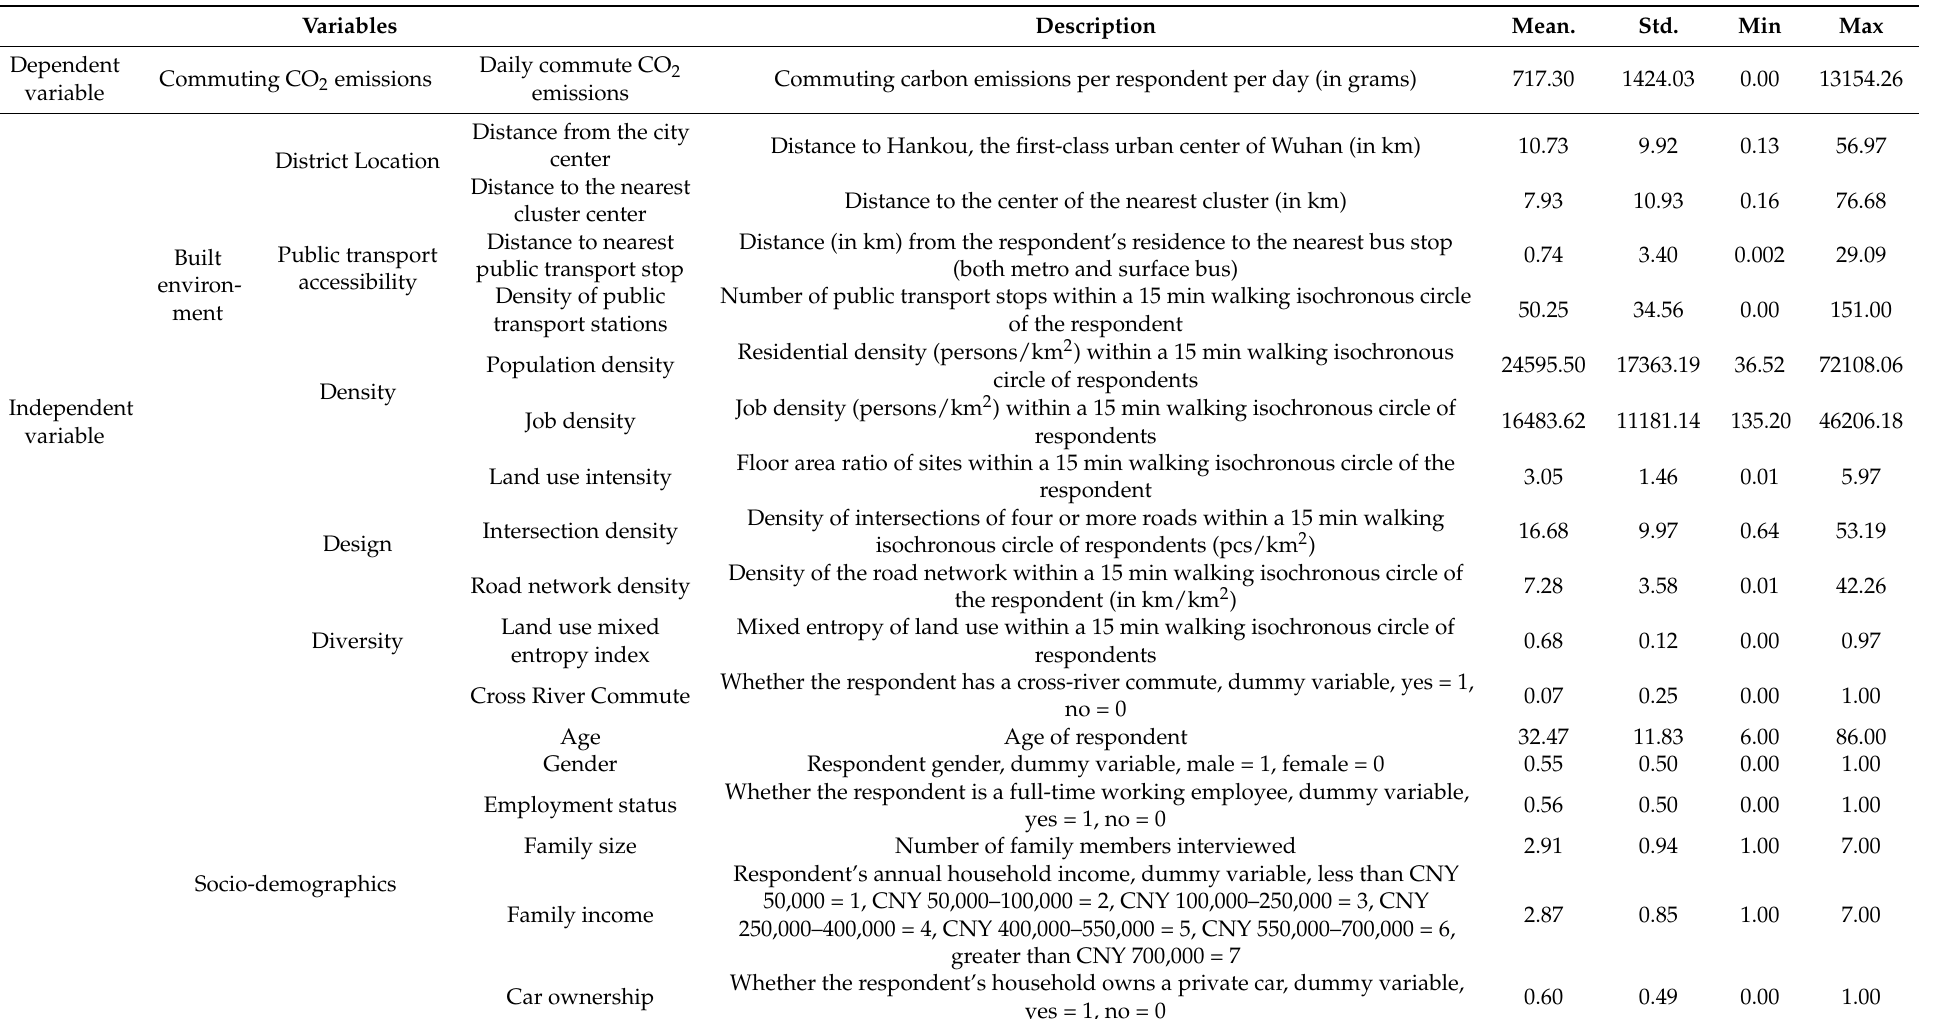
Table 3. Variable statistics